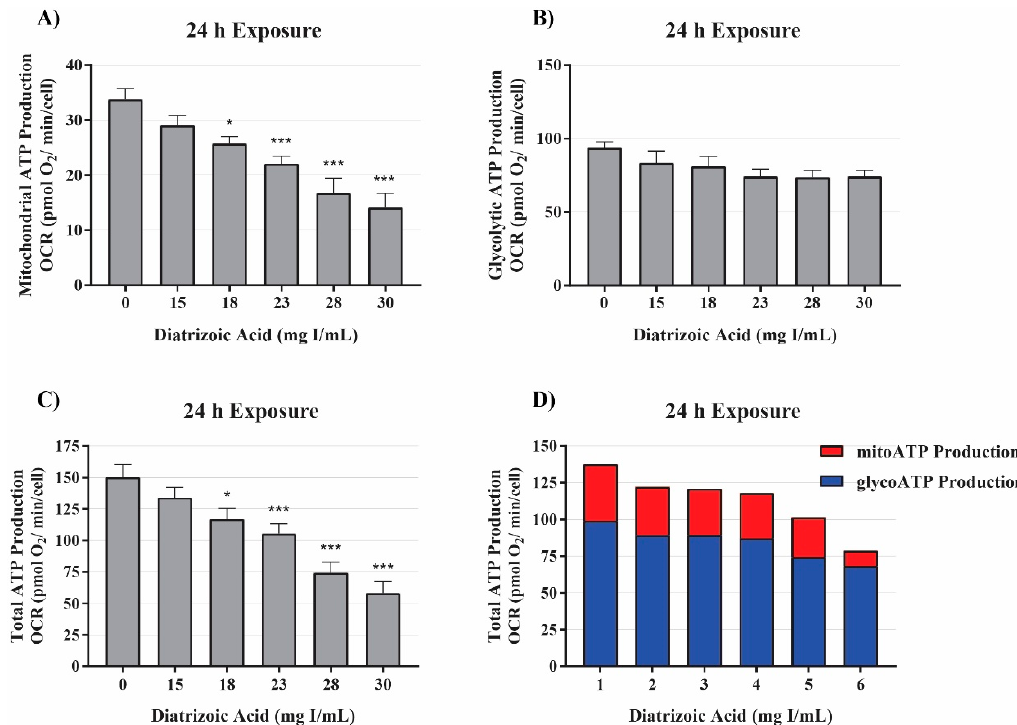
Figure 5. Diatrizoic acid effects on mitochondrial, glycolytic, and total ATP production. DA diminished ATP production linked to mitochondrial respiration ( A ) and total ATP production ( C ) but not glycolytic ATP production ( B ) following 24 h exposure. Representative graph of ATP production of the real-time ATP rate assay following exposure to DA for 24 h ( D ). Statistical difference from 0 mg I/mL DA depicted by an asterisk (* p < 0.05, *** p < 0.001). Values represent mean ± SEM for three independent experiments.